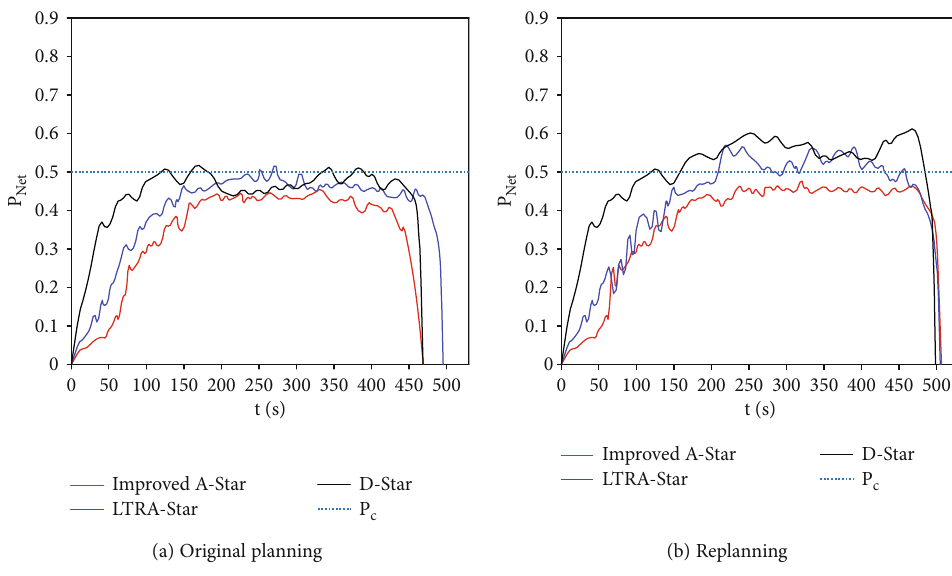
Figure 10: The detection probability of netted radar in the second threat Table 6: The geographical location and types of threat sources in Table 5: The statistical result of fl ight in the second scenario. the third threat scenario.